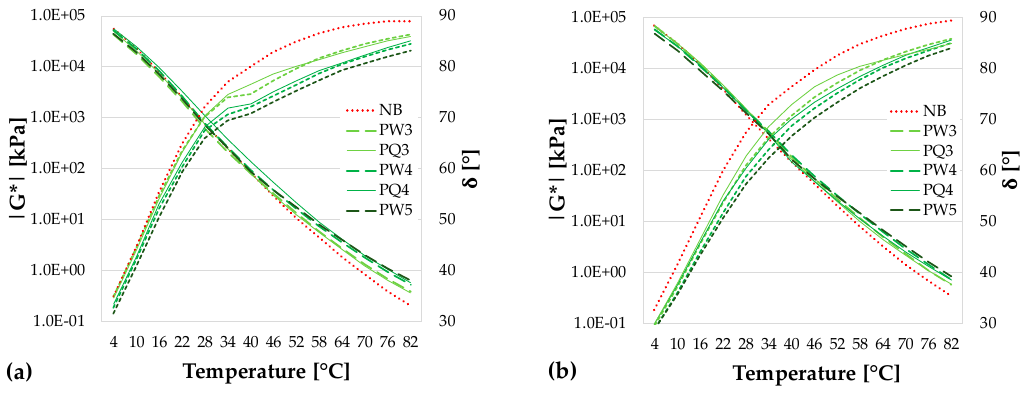
Figure 5. Complex modulus and phase angle isochrones (at 10 rad/s) of PBR-modified binders: ( a ) unaged binders; ( b ) RTFO-aged binders.